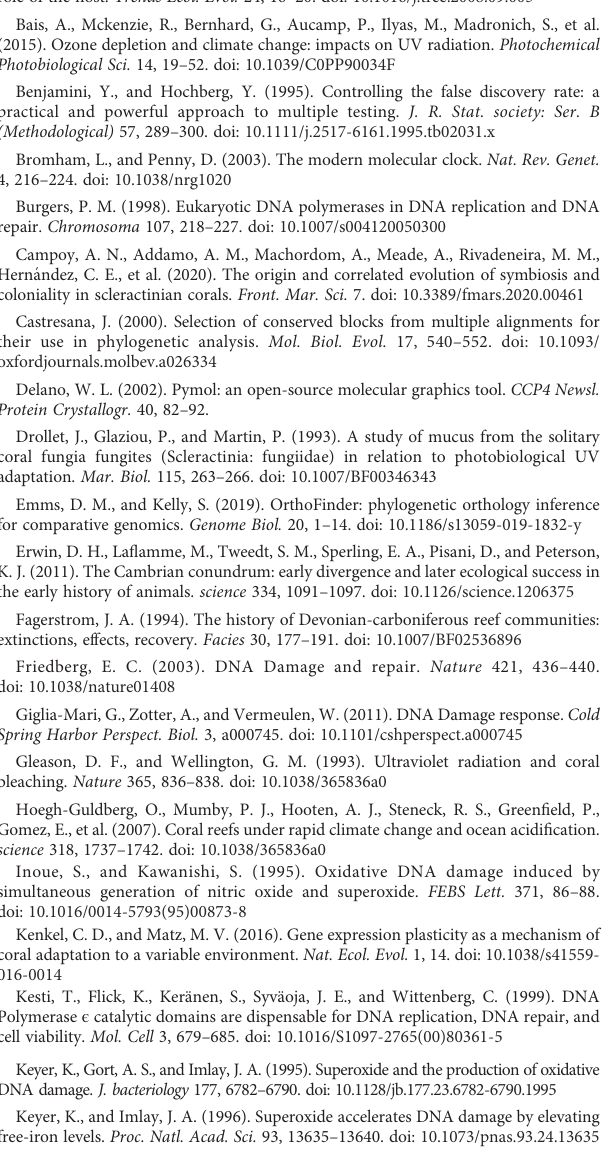
SUPPLEMENTARY TABLE 6 The results of GO and KEGG